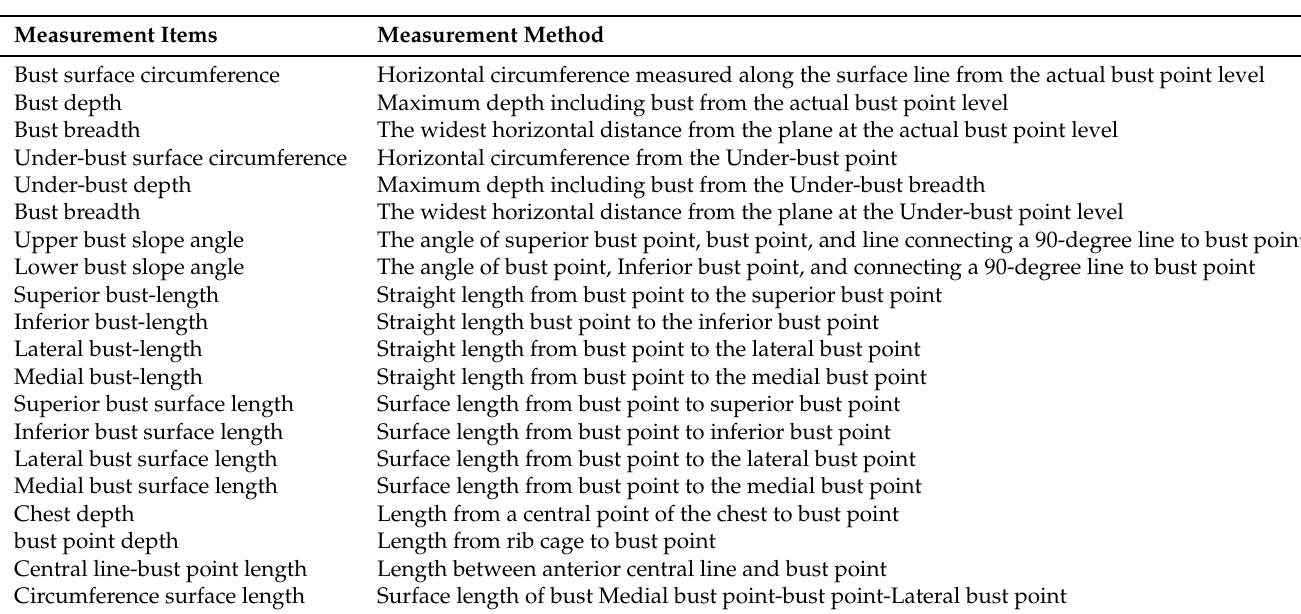
Table 4. Measurement method for